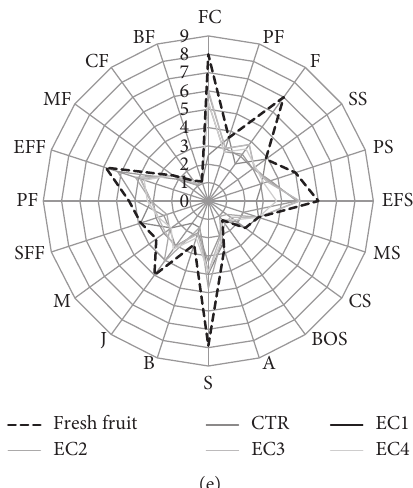
Figure 5: Sensory profile of papaya fruits after (a) 0 (T0), (b) 3 (T3), (c) 6 (T6), (d) 9 (T9), and (e) 12 (T12) days of cold storage at 5 ° C and 90% RH. Flesh color (FC), presence of filaments (PF), firmness (F), smell of sea (SS), smell of peach (PS), smell of exotic fruit (EFS), smell of medicines (MS), smell of cheese (CS), smell of burnt oil (BOS), acid (A), sweet (S), bitter (B), juiciness (J), mealy (M), seafood flavor (SFF), peach flavor (PF), exotic fruit flavor (EFF), medicinal flavor (MF), cheese flavor (CF), and burnt oil flavor